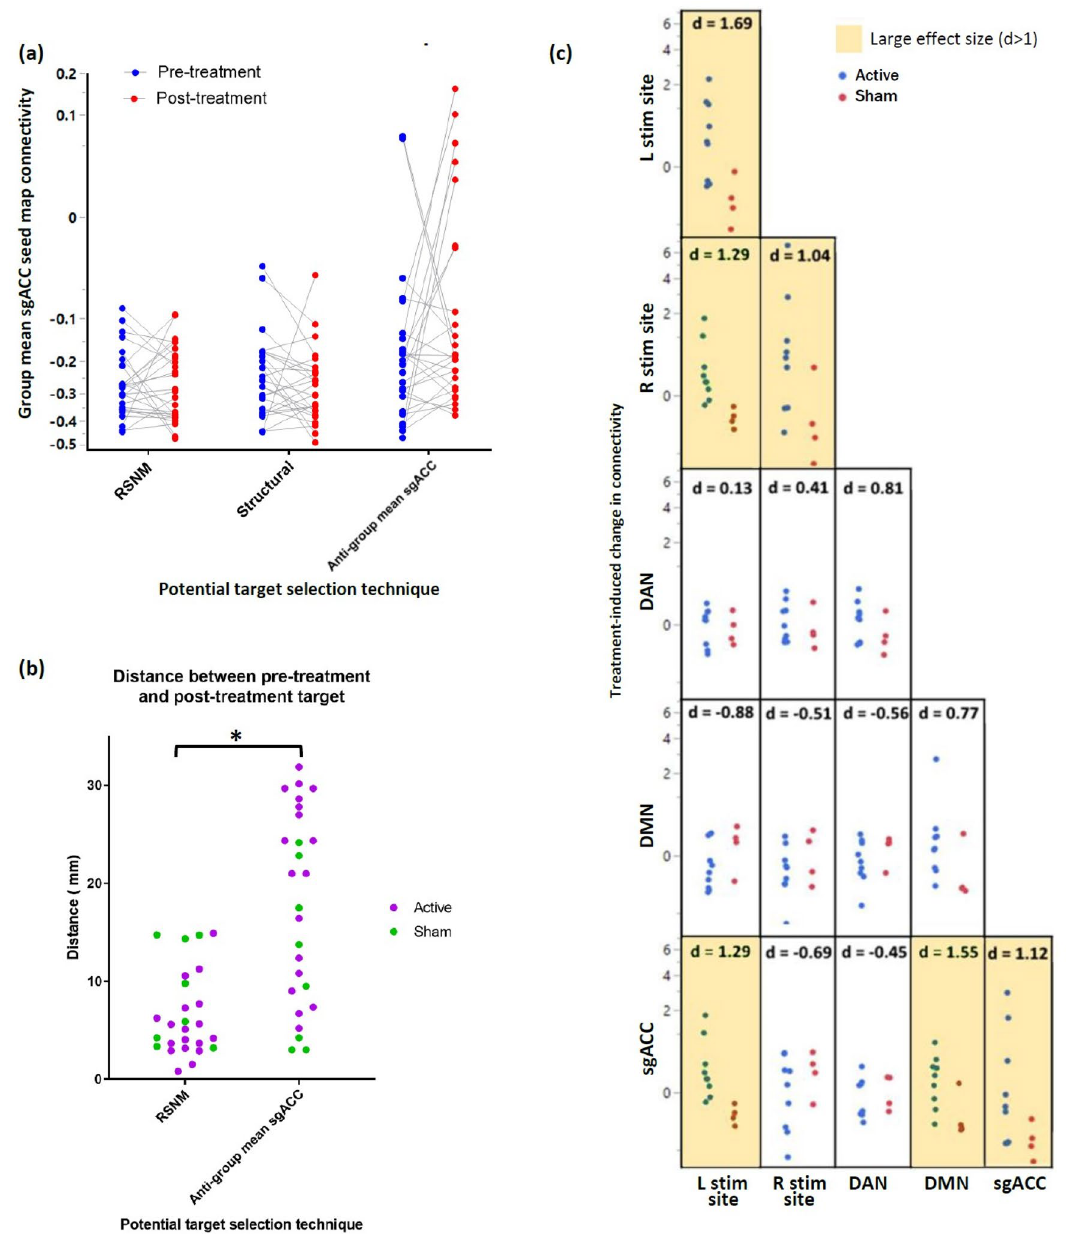
Figure 5. ( a ) Change in connectivity profile of left- and right-sided potential targets identified based on pre- treatment and post-treatment scans. Group mean sgACC seed map connectivity remained relatively stable for RSNM targets and structural targets but was more unstable for the potential sgACC-derived targets. Each symbol represents 1 target; there were 2 targets per subject (right and left) × 13 subjects who underwent either active or sham rTMS treatment. ( b ) Spatial change in target coordinates between pre-treatment and post- treatment scans. After a course of RSNM-targeted treatment, the location of the potential sgACC-derived target sites changed significantly more than the location of RSNM-based target sites (p < 0.0001, Wilcoxon matched- pairs signed-rank test). ( c ) Treatment-induced change in connectivity within and between a priori ROIs. Active treatment was associated with connectivity changes within and between stimulation sites, sgACC, DAN, and DMN. Magnitude of change is quantified using Cohen’s d (adapted with permission from Siddiqi et al., J Neurotrauma